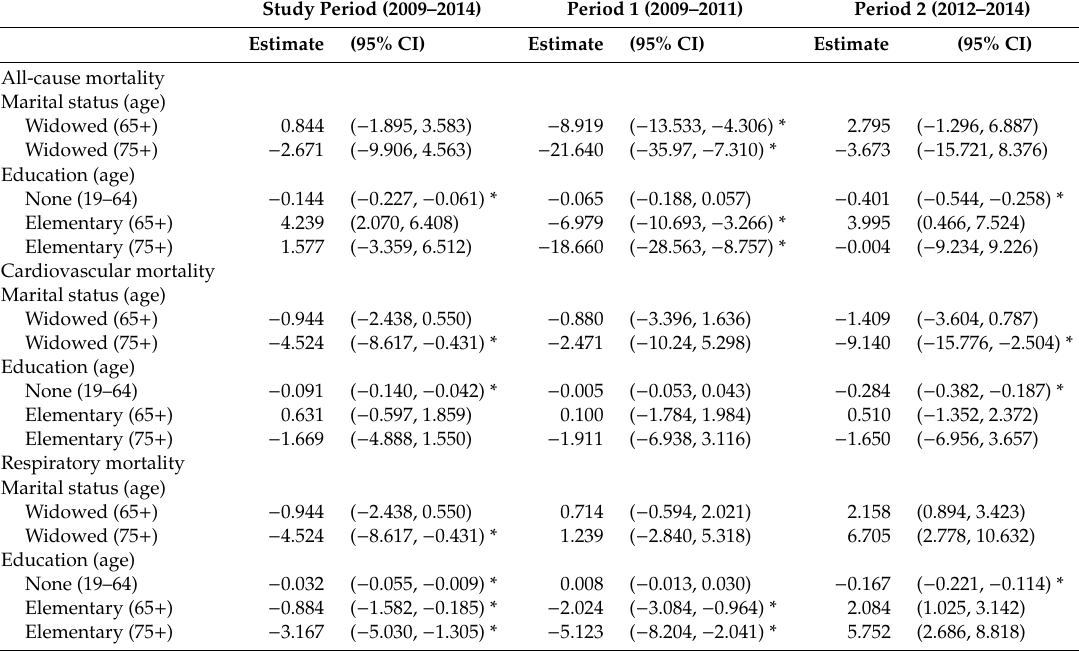
Table 4. Trend in the e ff ects of the heat wave warning system on changes in cardiovascular and respiratory mortality per 1,000,000 people per